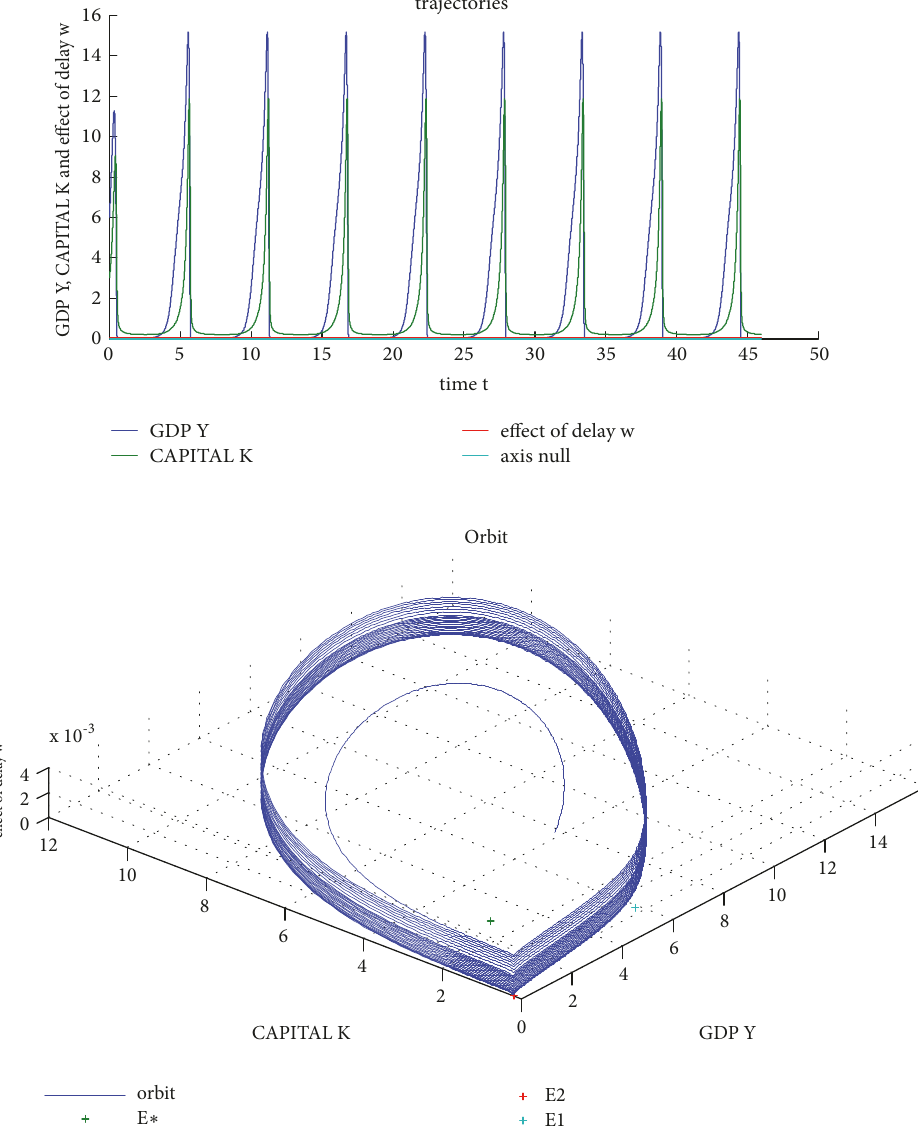
Figure 1: Trajectories and orbits with 𝑢 0 (𝜃) = 𝜑(𝜃) = 𝑢(0)𝑒 𝐴𝜃 /(1 + 𝑢(0)(𝑒 𝐴𝜃 − 1)) , ∀𝜃[−𝑇;0] , where 𝐴 = (1/2𝑇) ln {|𝑢(0) − 1|/𝑢(0)} if 𝑢(0) ̸= 1 and 𝐴 = −1/2𝑇 if 𝑢(0) =